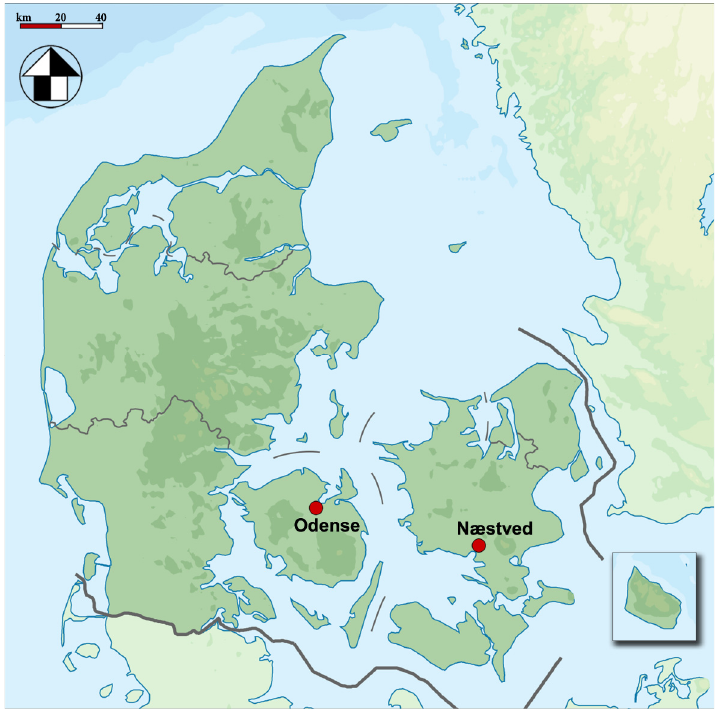
Figure 1. Map of Denmark depicting the location of Odense and Næstved (CC0 1.0 Universal; edited). Graphic programs used: Adobe Photoshop CS5.1 and Adobe Illustrator CS5.1.